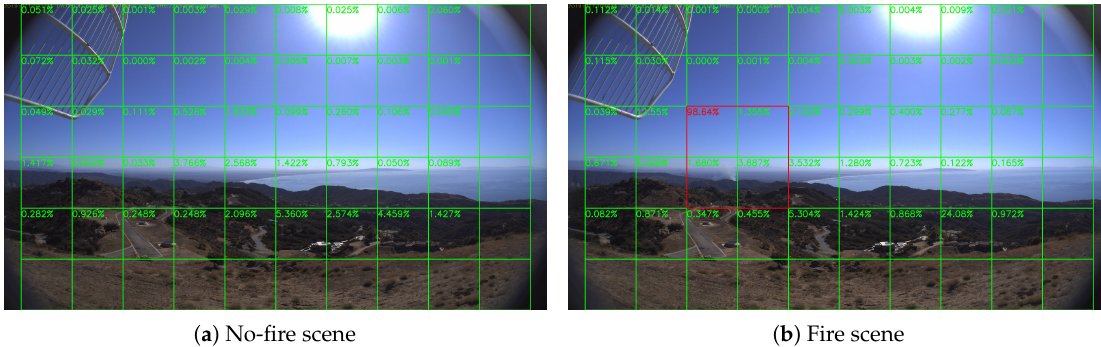
Figure 9. Palisades fire, 21 October 2019.